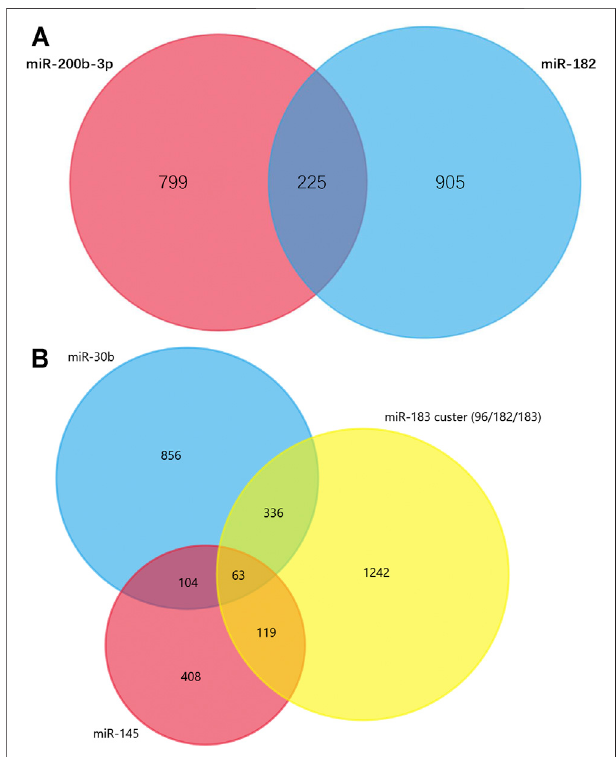
FIGURE5| Venndiagramanalysis. (A) OverlappingtargetgenesofmiR- 182 and miR-200b in cerebral cortex. These down-regulated genes were showed in Supplementary Table S2 and have been observed in more than one studies. (B) Overlapping target genes of miR-96, miR-182, miR- 183, miR-145 and miR-30b in dorsal root ganglions. These fi ve down- regulated genes were showed in Supplementary Table S4 and have been observed in two or more experimentally veri fi ed studies. miR-96, miR-182, miR-183 formed miR-183 cluster, so their target genes were